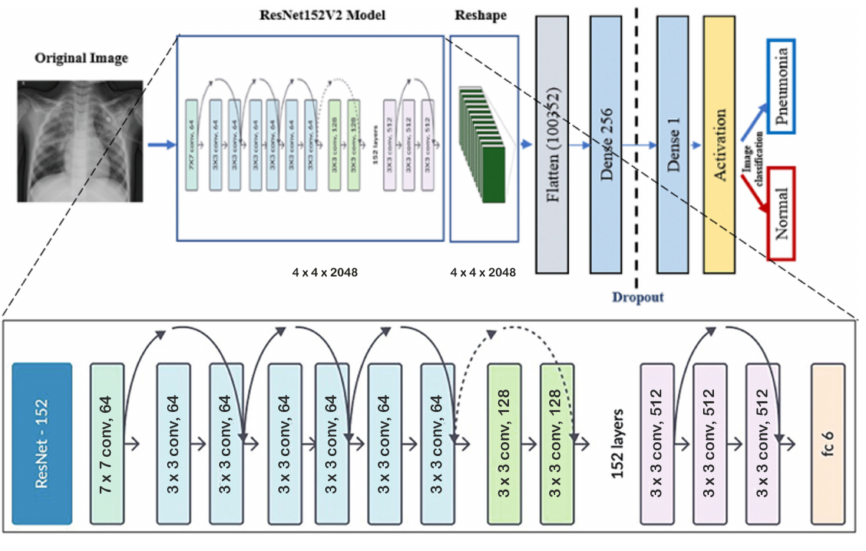
Figure 13. Layers of